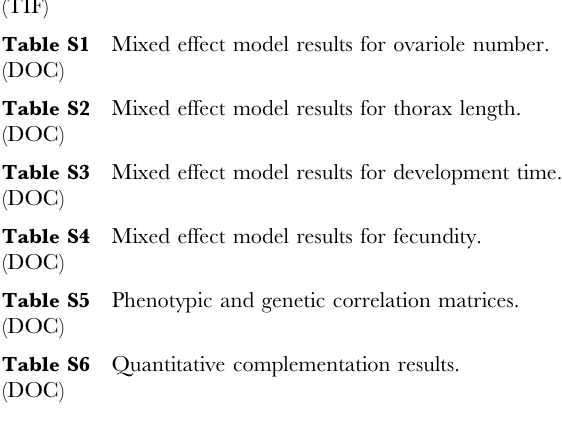
Table S7 RNAi over expression